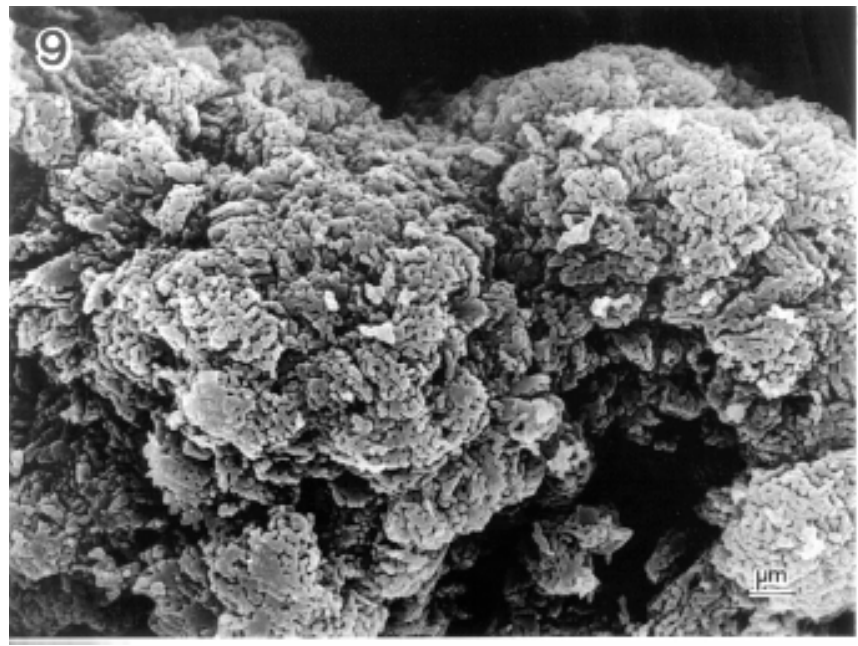
Fig. 9 – SEM of two agglomerates of alpha-alumina after being heated at 1300 ◦